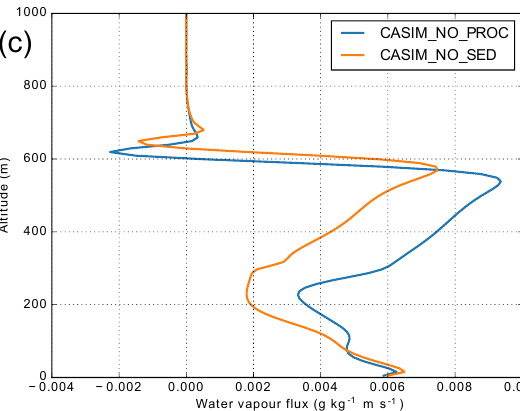
Figure 12. Domain-average vertical profiles of (a) vertical velocity variance (m 2 s − 2 ), (b) buoyancy flux (Kms − 1 ), and (c) water vapour flux (gkg − 1 ms − 1 ), calculated as temporal means between 05:30 and 07:00UTC for CASIM_NO_PROC (blue) and CASIM_NO_SED (orange).